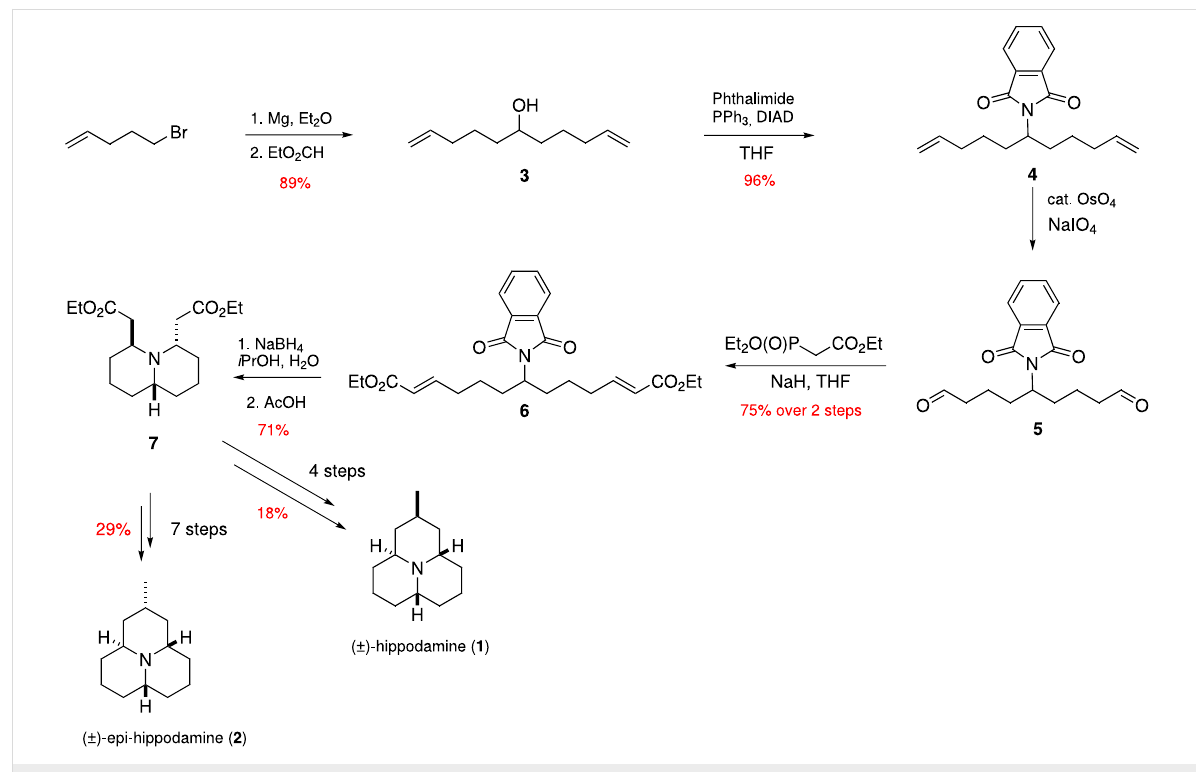
oids contained in a reflex bleed released when the ladybird is attacked. To date, eight alkaloids of this type have been isol- ated from coccinellid beetles [1], all of them being formally derivatives of perhydro-9b-azaphenalene (Figure 1).